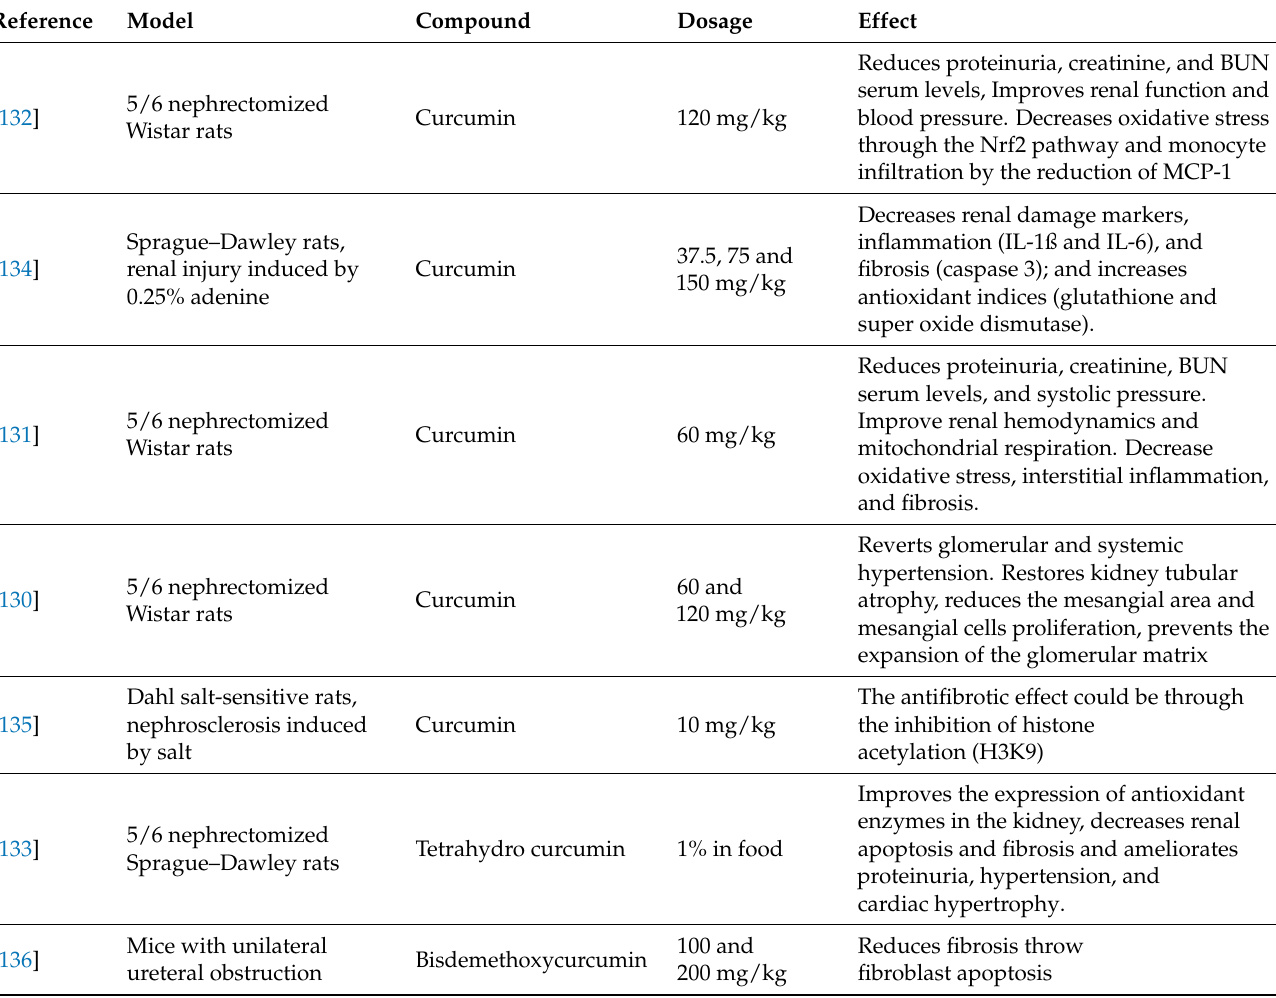
Table 1. Curcuminoids’ effects on chronic kidney disease (CKD)